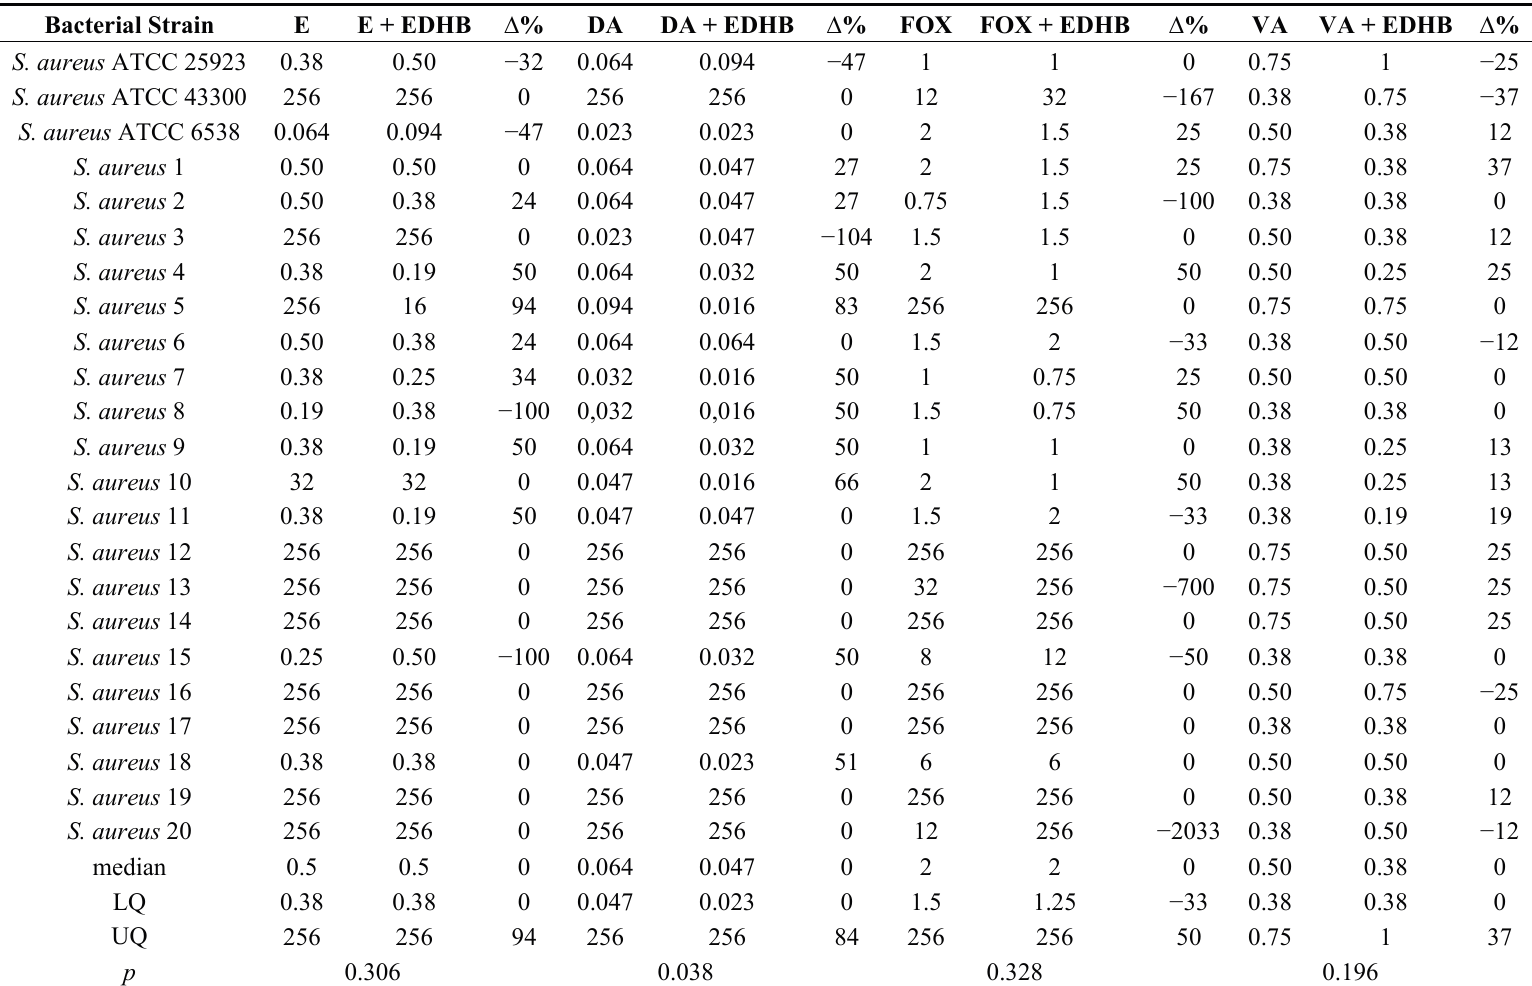
Table 3. Staphylococcus aureus susceptibility to methicillin and MLS B antibiotics assessed by disc diffusion method (Cefoxitin test and D-test) and molecular technique (detection of mecA